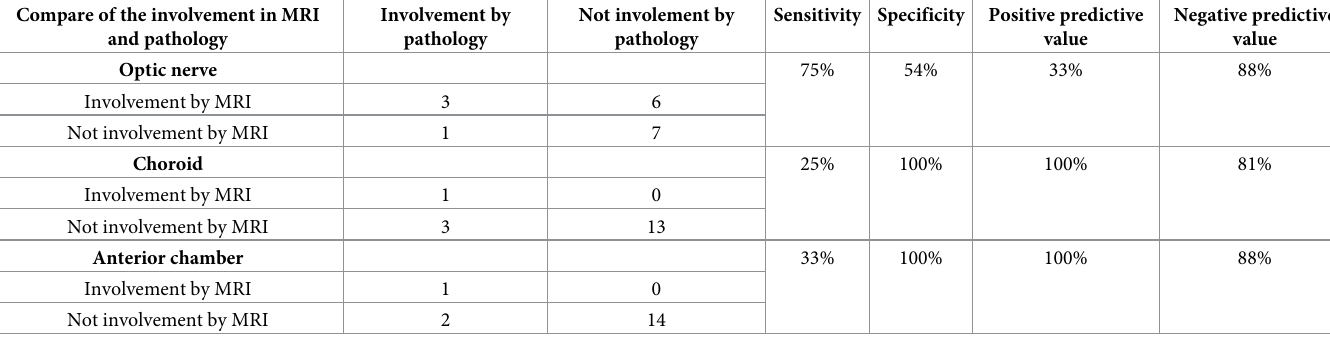
Table 6. The sensitivity and specificity of the MRI for predict the optic nerve involvement in retinoblastoma. Compare of the involvement in MRI and